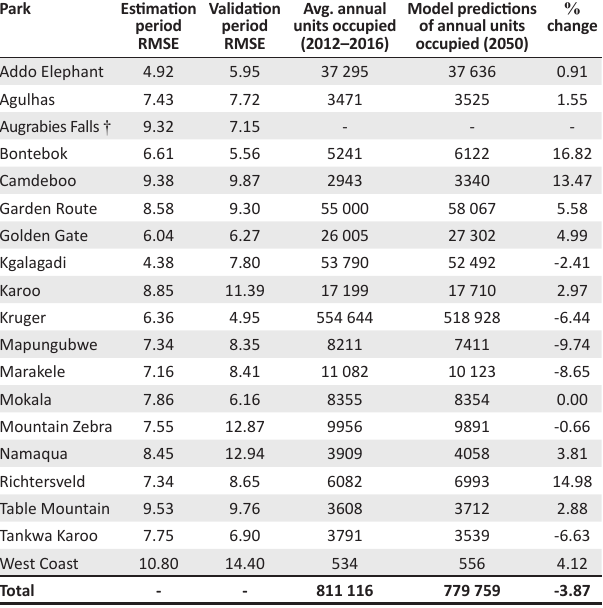
TABLE 4: Root mean square error for both the estimation and validation periods, and the predicted change in annual units occupied for each park based on the individual best-fit